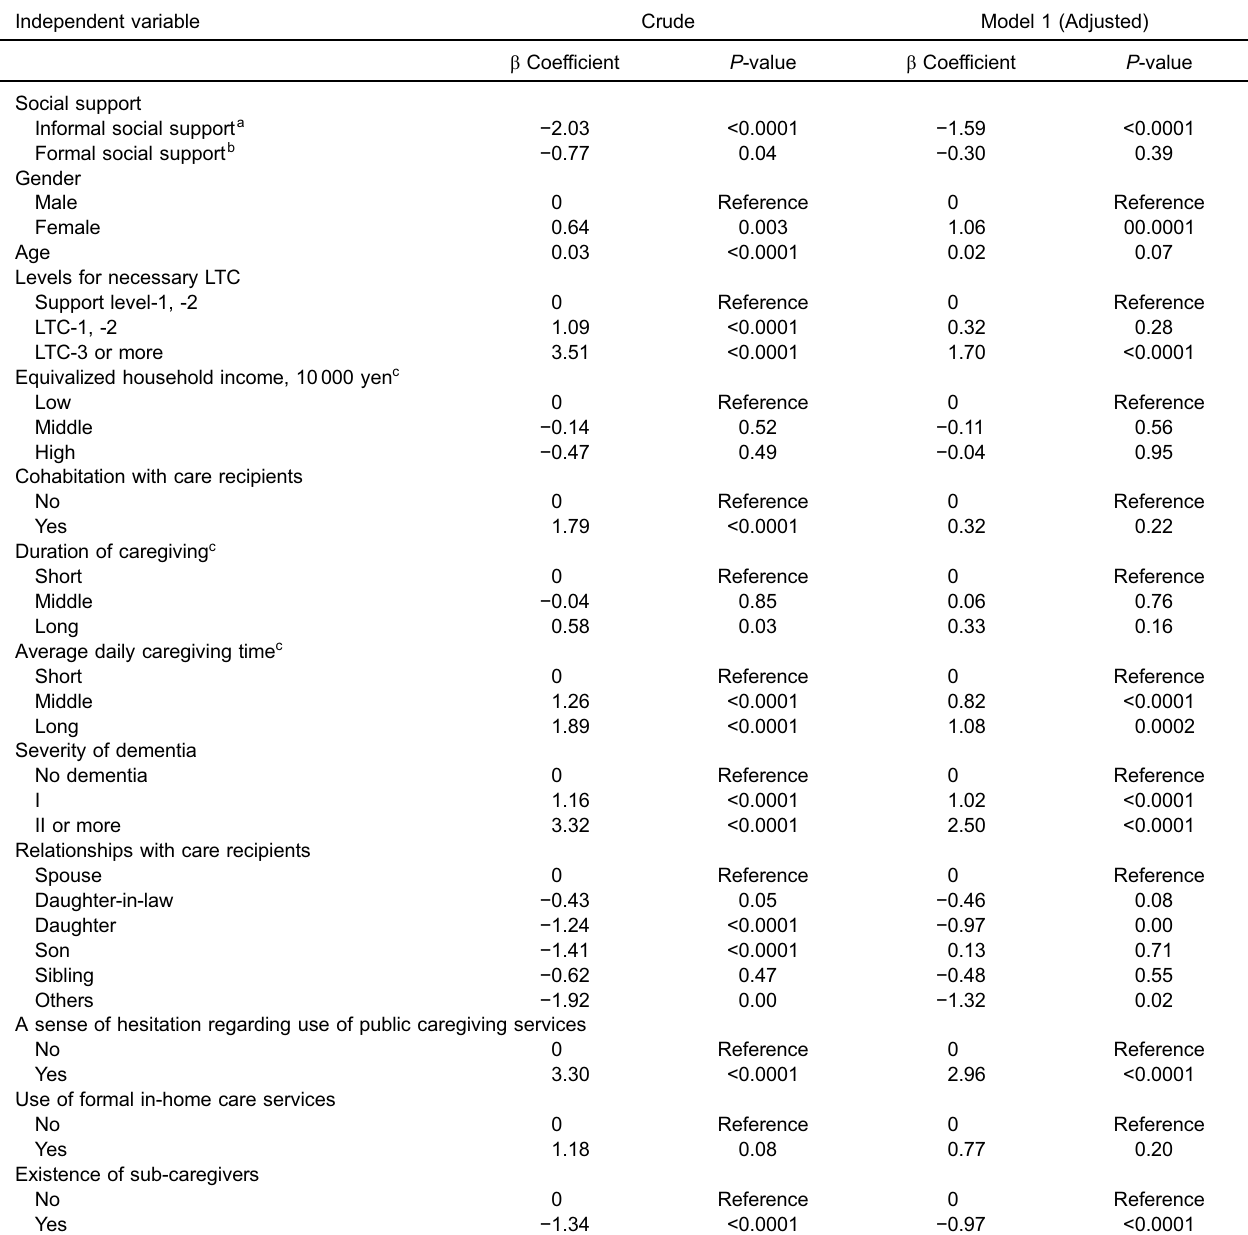
Table 2. Linear regression model for caregiver ’ s burden score by having informal and/or formal social support ( n = 2998) Independent